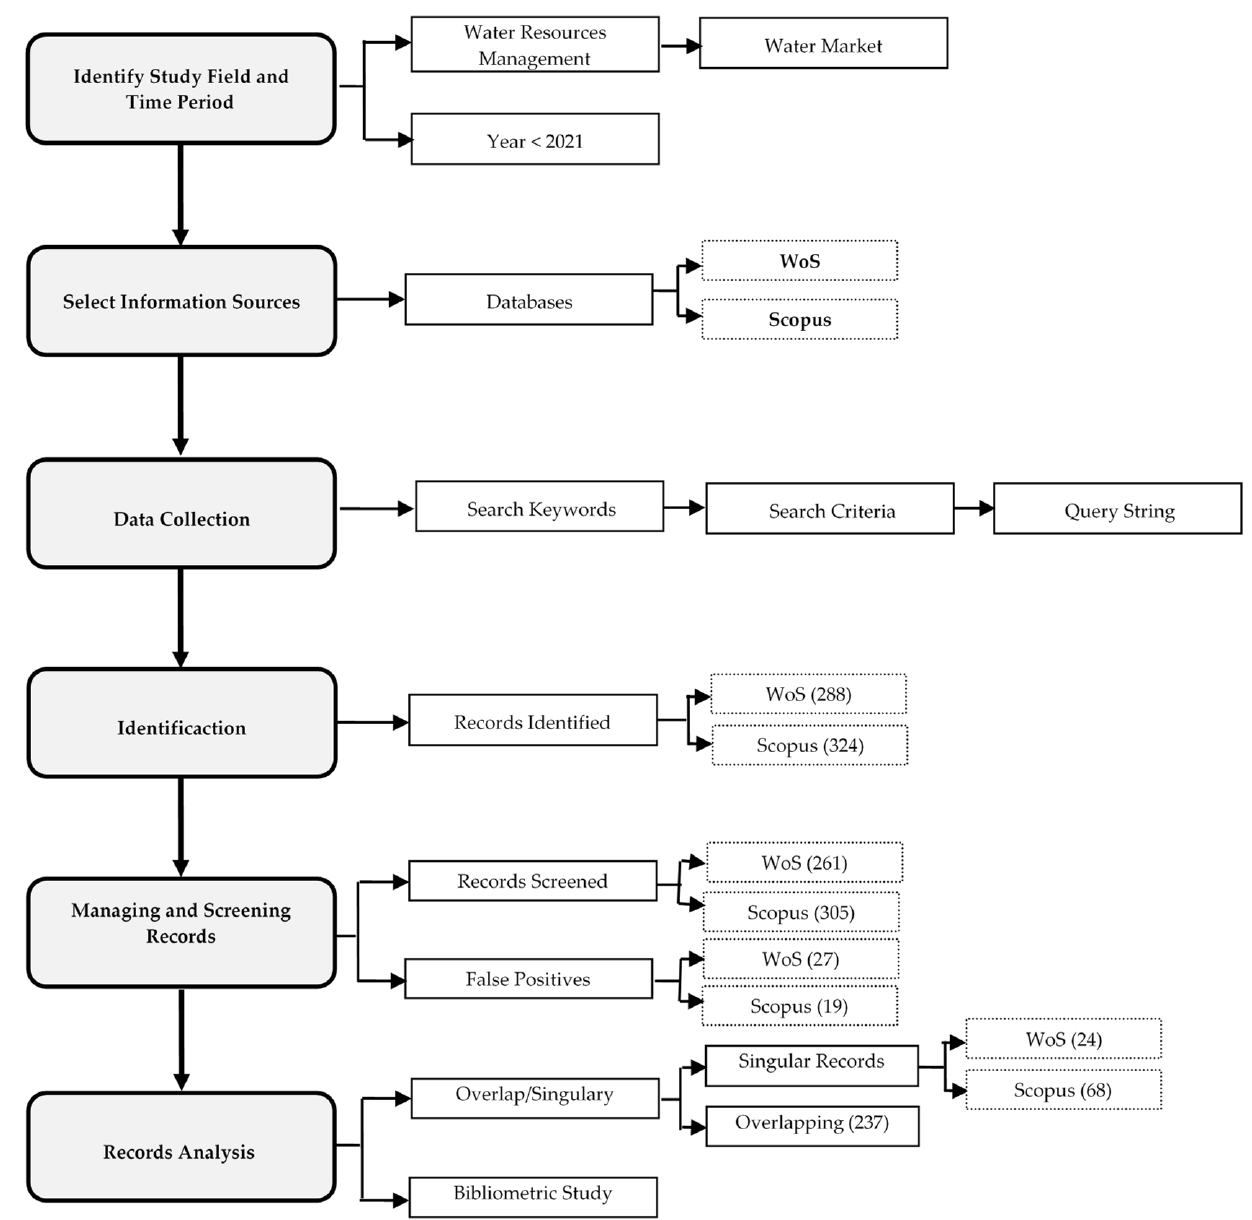
Figure 1. Methodological scheme. Source: own elaboration.